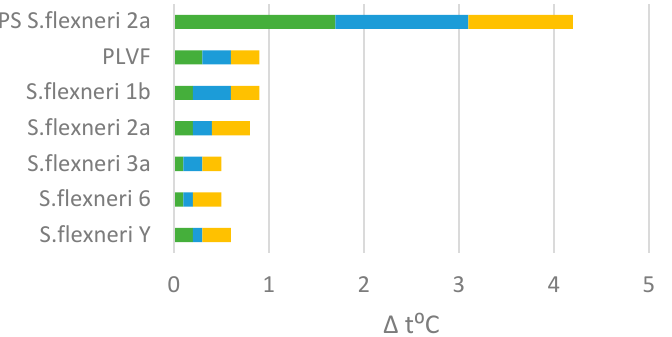
Figure 4. Comparative study of febrile response to PLVF, each Ac 3 -S-LPS vaccine component, and nLPS of S. flexneri 2a in the rabbit pyrogen test. For each group, the cumulative temperature rise was calculated using three rabbits. The stacked color bars represent each individual rabbit febrile response within a group.